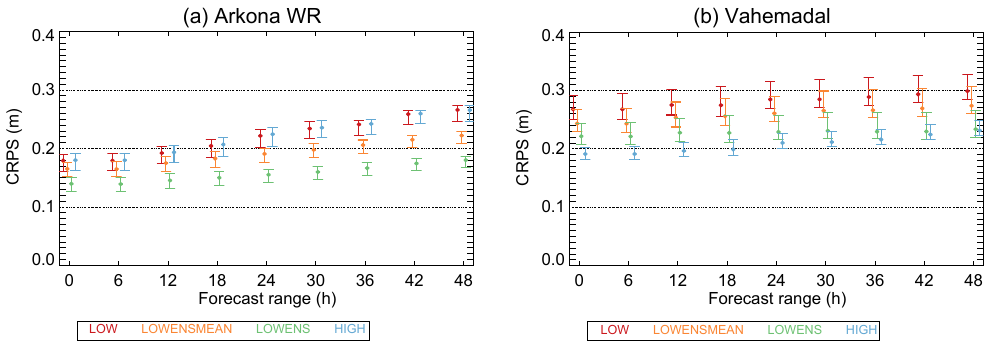
Figure 11. CRPS for selected forecast ranges for the Arkona WR (a) and Vahemadal sites (b) for the LOW, LOWENSMEAN, LOWENS and HIGH forecasts. Error bars show the 5% and 95% confidence bands calculated by bootstrapping.